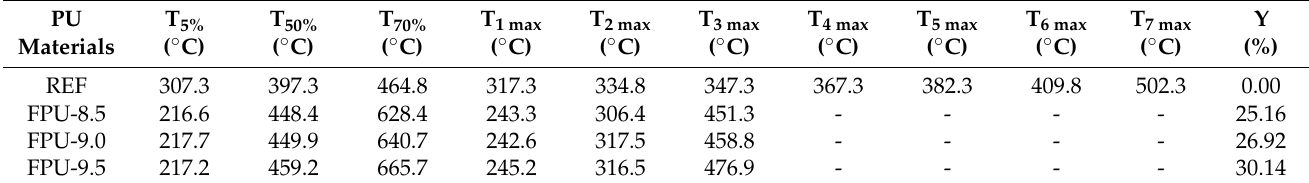
Table 5. TGA and DTG results for PU materials tested under air atmosphere.